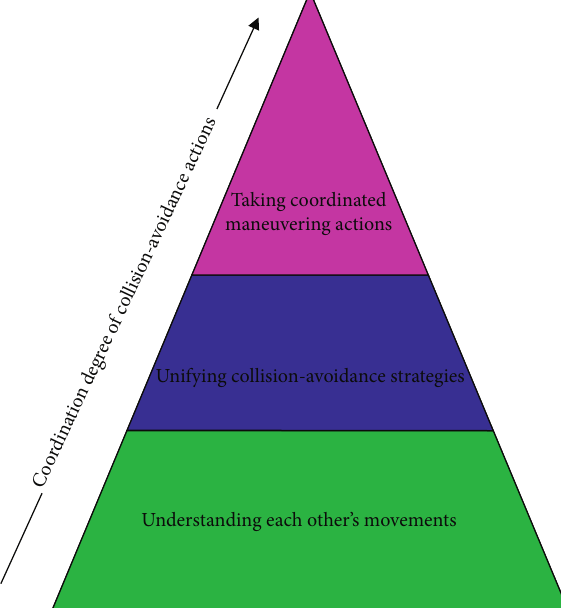
Figure 4: Coordination degree of collision-avoidance actions of two